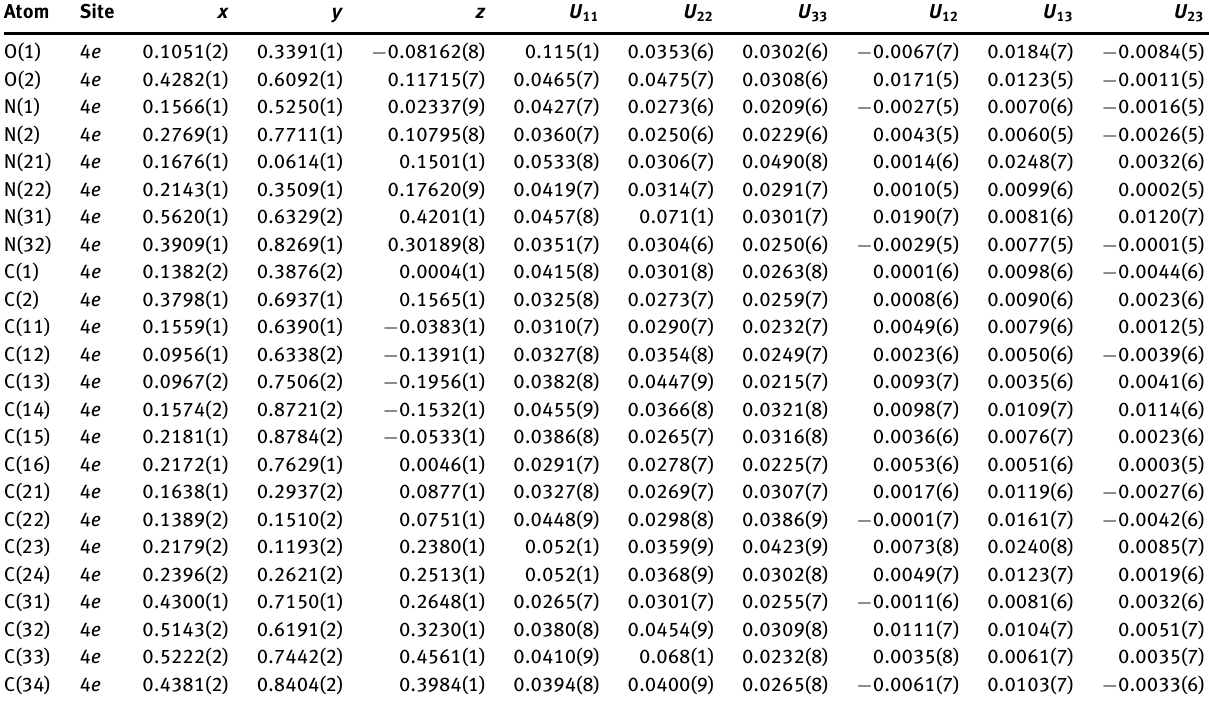
Table 3: Fractional atomic coordinates and displacement parameters (Å 2